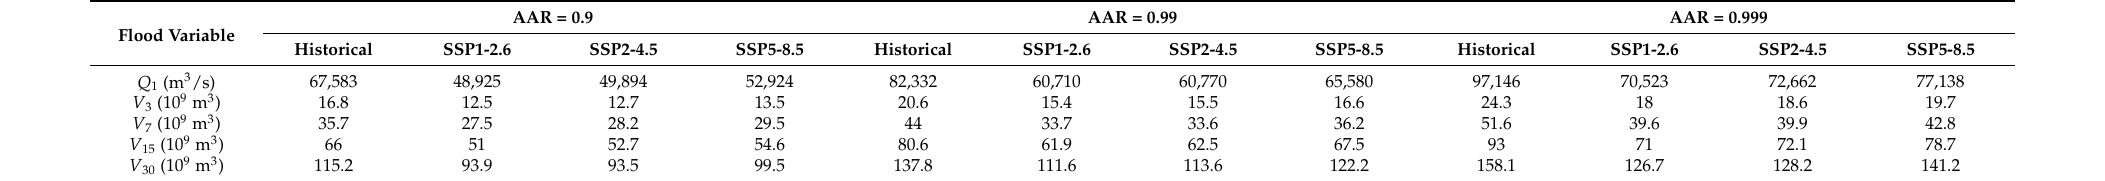
Table 4. Multivariate dam-site design floods associated with OR exceedance probability for the TGR.